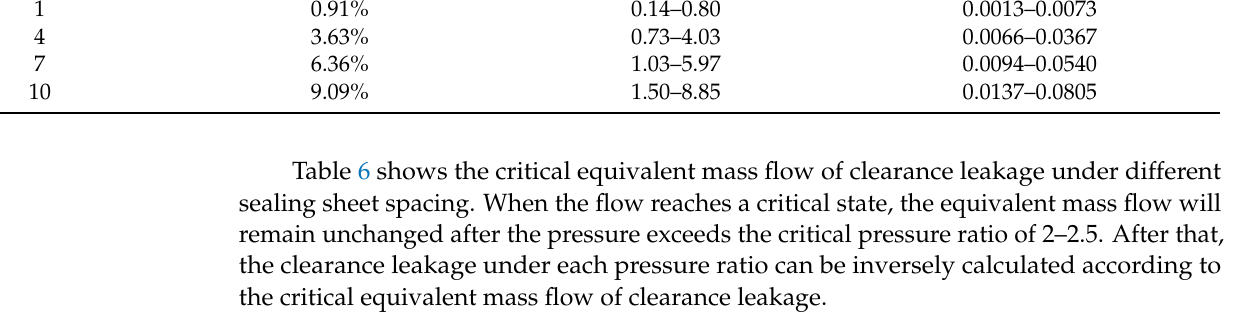
ance leakage under different sealing sheet spacing. ( a = 1.0 mm). ( a ) Clearance leakage against pressure ratio. ( b ) Equivalent leakage against pressure ratio.